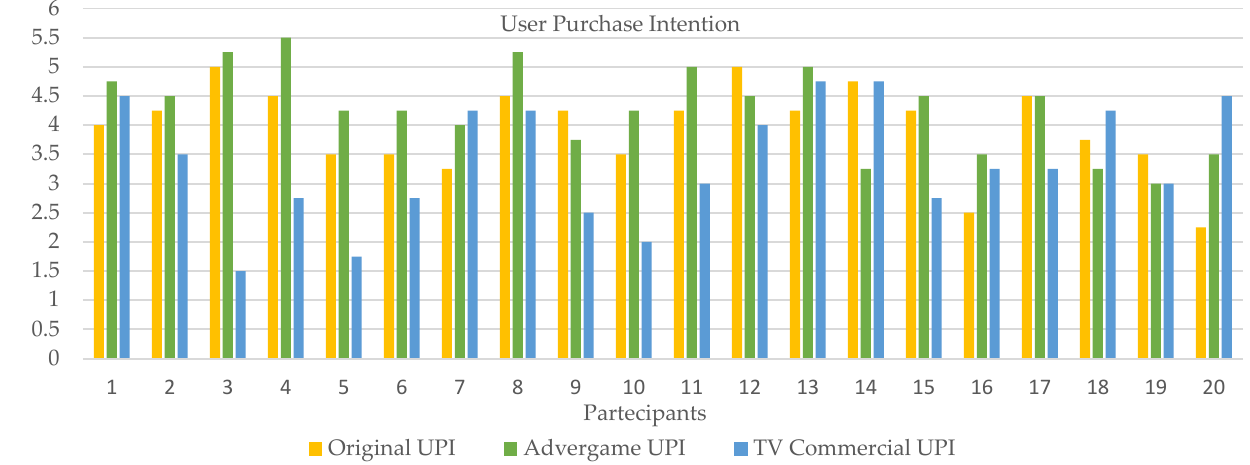
Figure 7. UPI before and after the advertising interactions.